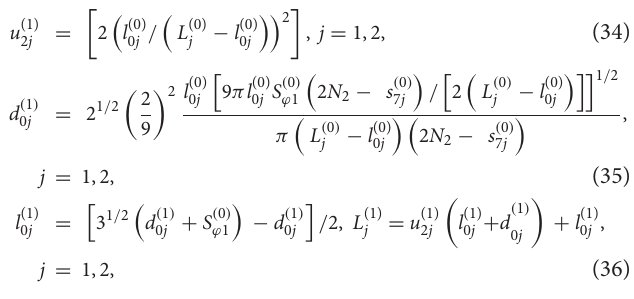
( Figure 2 ), taking into account δ min , δ max –the limits of change D y D y of the value D ( 1 ) y (m) from (29). Note that the right-hand side of (34) contains an integer value from the corresponding relation. In the next ( Figure 2 ), the